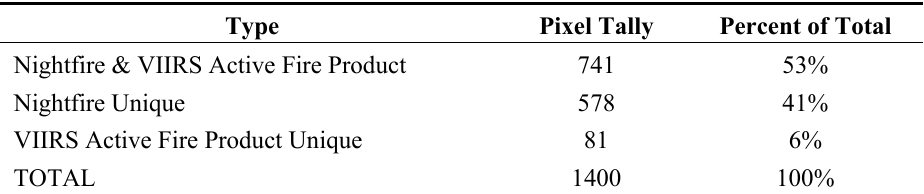
Table 3. Intercomparison of VIIRS Active Fire vs. Nightfire Pixel Detection Numbers in Sumatra from 19 June 2013.